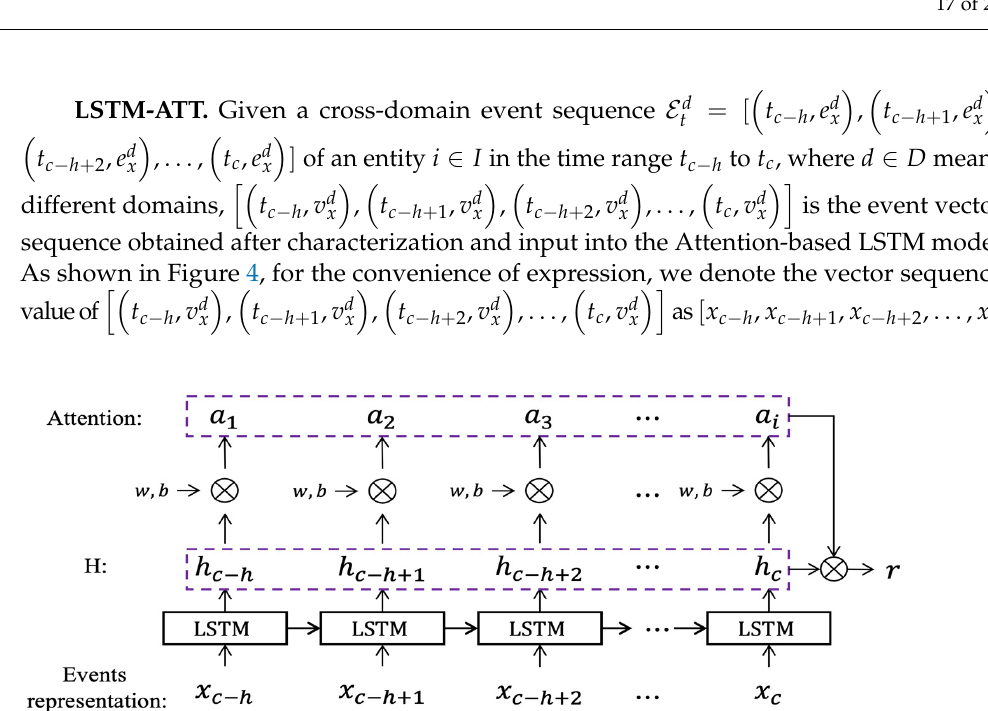
Figure 4. Attention-based LSTM Model (LSTM-ATT): This model aims to calculate the weighted representation r of the event vector. [ x c − h , x c − h + 1 , x c − h + 2 , . . . , x c ] is the input event sequence, w and b are the weight vector and bias vector of the softmax layer, respectively, a i is the attention weight of each event.